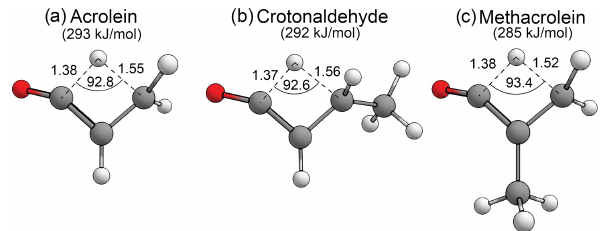
Figure 10. Optimised B2GP-PLYP-D3/def2-TZVP S 0 TSs and zero-point vibrational-energy-corrected threshold energies for enal– ketene tautomerisation, as shown. Key structural parameters in angstroms (Å) and